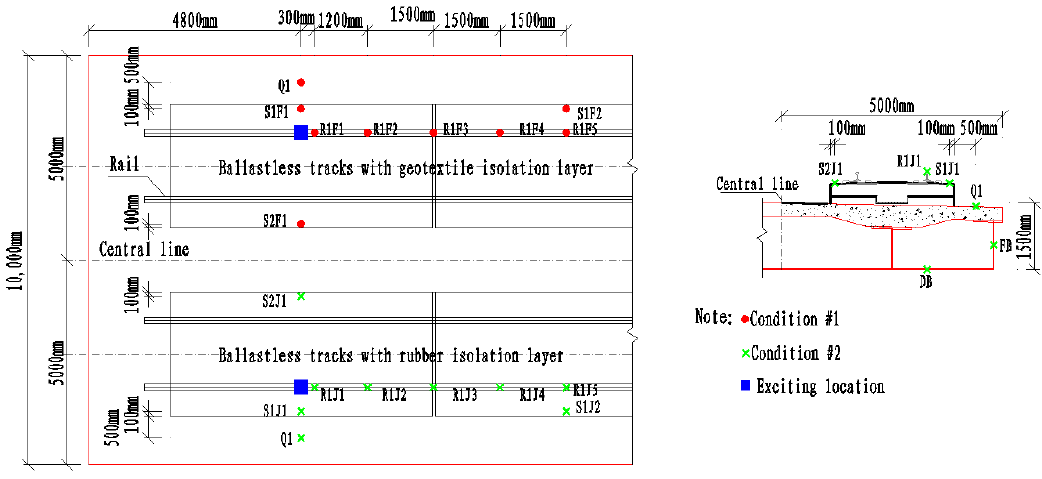
Figure 6. Arrangements of measuring sensors.